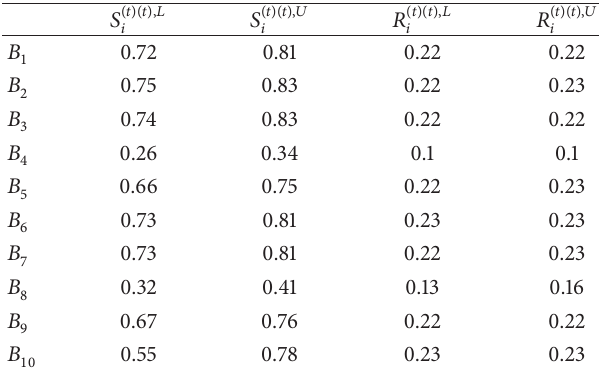
Table 12: 𝑆 and 𝑅 interval numbers (year of 2004-year of 2004).